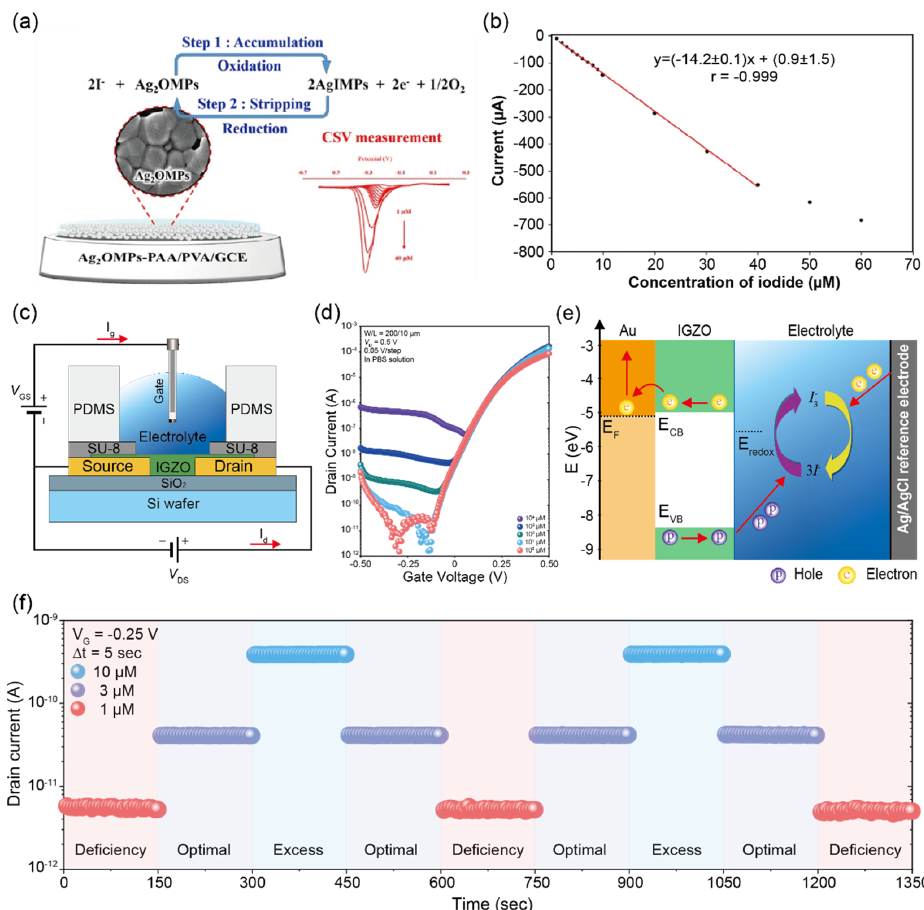
Figure 14. Selective detection of iodide ions in clinical samples ( a ) Schematic diagram of detection principle for iodide ions sensors. ( b ) Changes in the current of the biosensor with increasing iodide concentration under optimal conditions. Standard calibration curves of iodide were plotted with different iodide ion concentrations in the range from 1 to 40 µM (reprinted with permission from ref. [54]; copyright 2020, Springer). ( c ) Schematic diagram of the device structure and electrical connections. Ag/AgCl reference and Au electrodes are used as the gate and source/drain electrodes, respectively. ( d ) Transfer curve of IGZO ‐ EGTFT with different iodide ion concentrations in the range from 10 to 10 4 µM in PBS solution. The drain current was measured at V G = –0.3 V and V D = 0.5 V. ( e ) Energy band diagram of Au/IGZO ‐ electrolyte ‐ Ag ‐ AgCl showing the hole and electron transport path by the redox reaction of iodide ions. ( f ) Real ‐ time source ‐ drain current response dynamic switching every 5 s for the iodide ions status in samples from school children based on the World Health Organization guideline. (Reprinted with permission from ref. [55]; copyright 2022, Elsevier.)